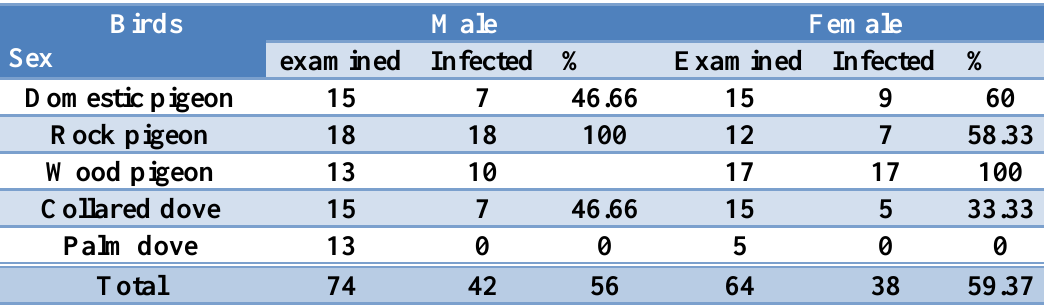
Table, 5: The prevalence rates of cestodes infection according to sex.